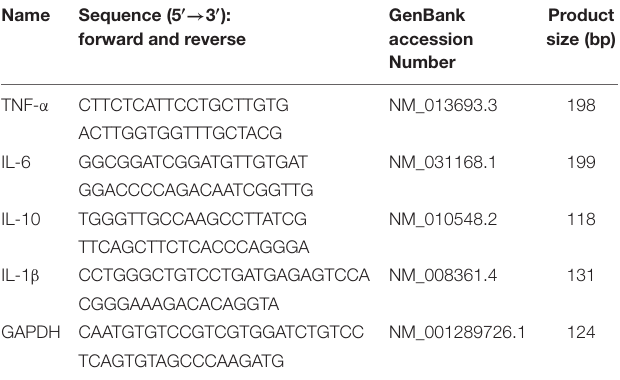
TABLE 1 | Sequence of primers used for quantitative real-time PCR.